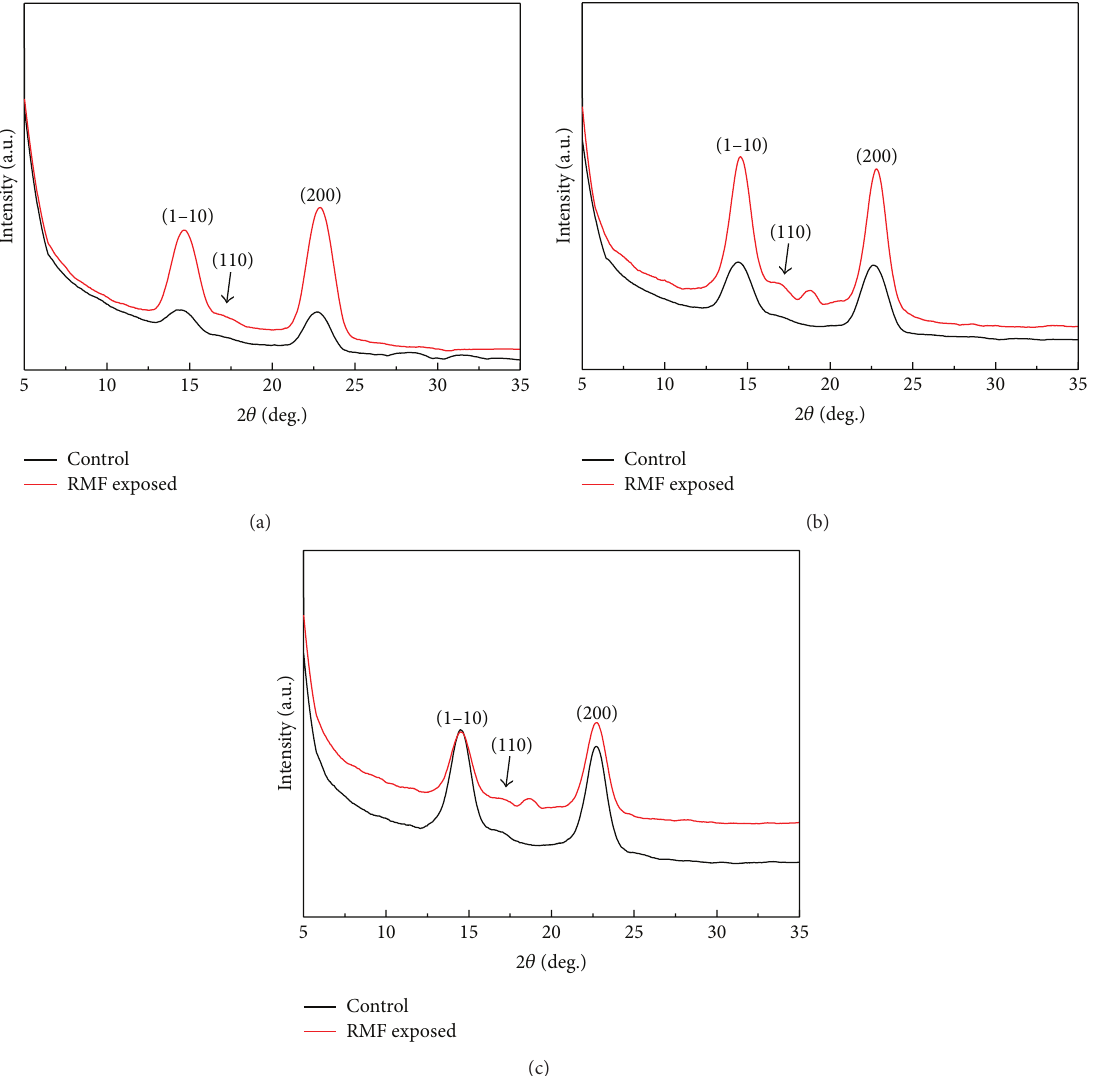
Figure 5: XRD patterns of BC pellicles obtained after (a) 3, (b) 5, and (c) 7 days of